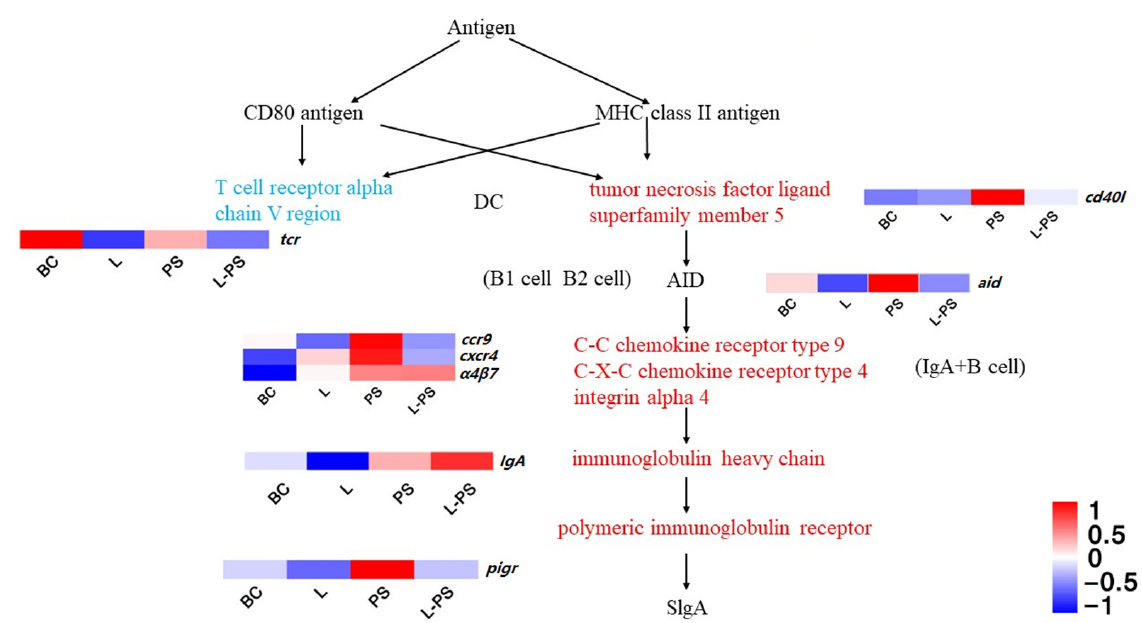
Figure 8. Intestinal immune network for IgA production.